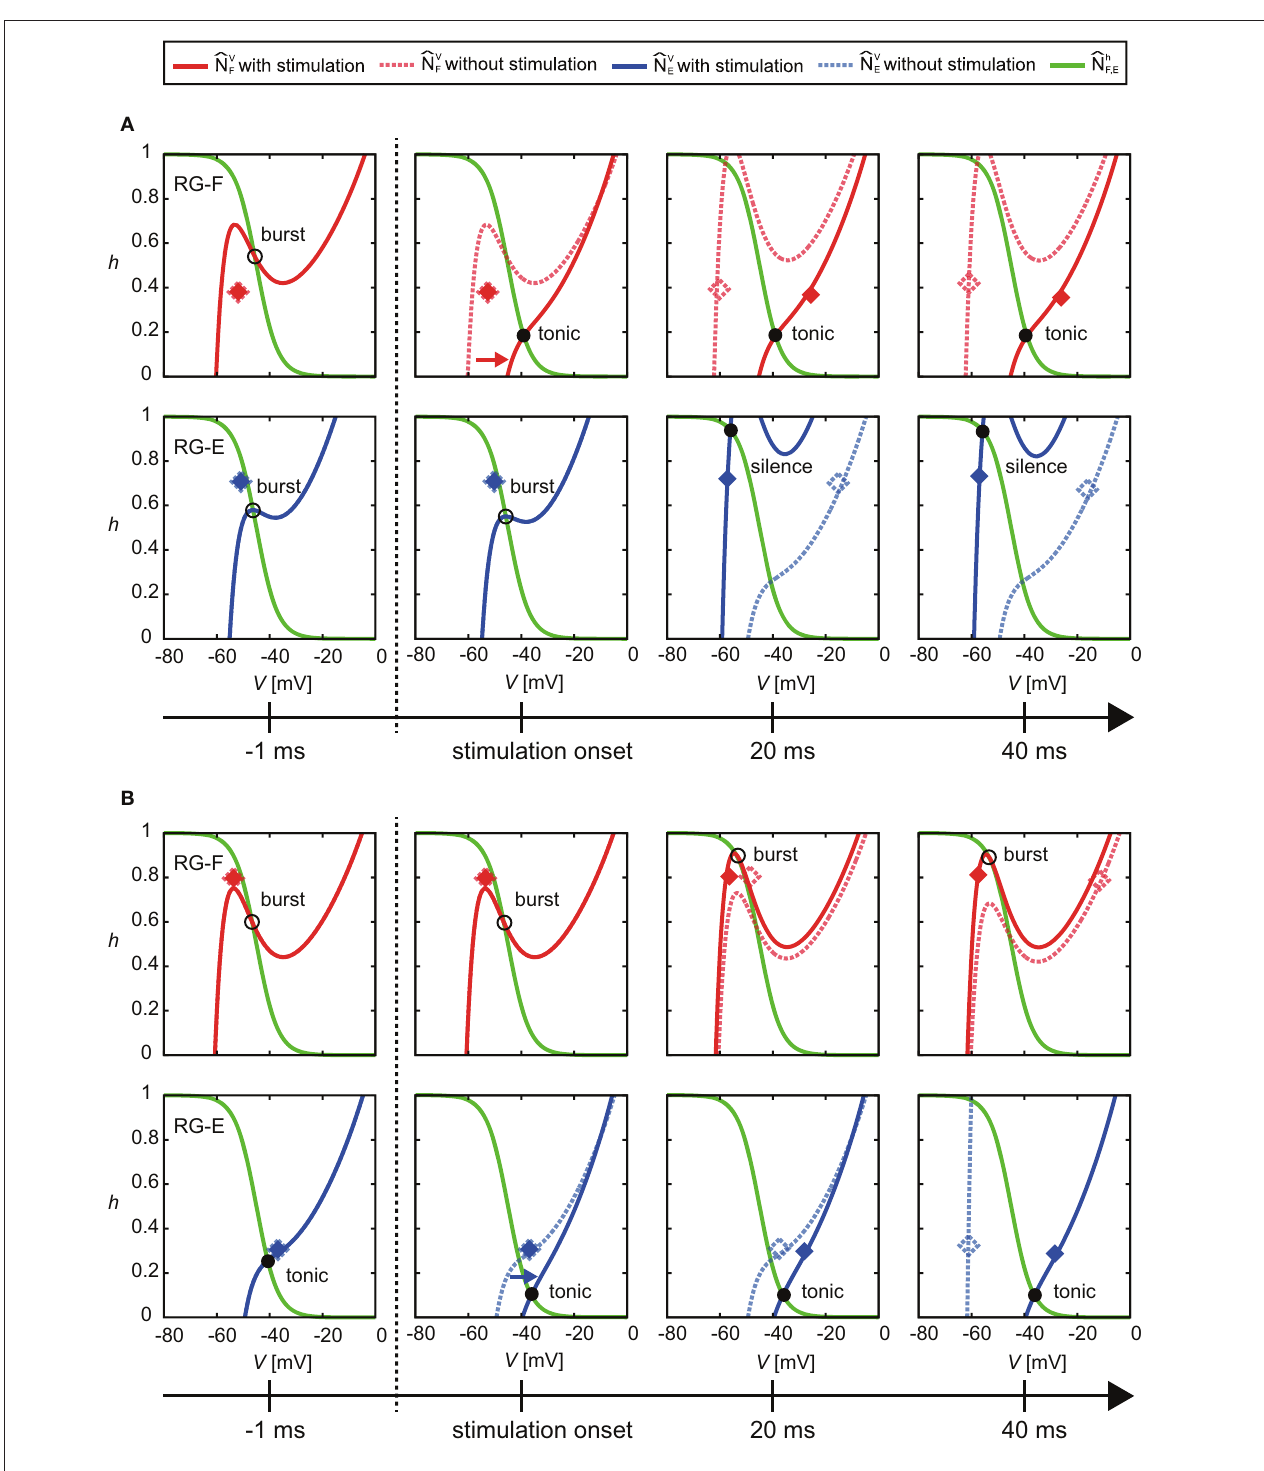
FIGURE 7 | Change of ˆ N V F and ˆ N V E by stimulation at the end of the active phase of (A) the flexor side ( φ s = 2.39rad) and (B) the extensor side ( φ s = 5.91rad). Solid and dotted lines show the results of the cases with and without the stimulation, respectively. Red and blue diamonds mark the positions of ( V F , h F ) and ( V E , h E ), respectively (filled diamonds for stimulation and open diamonds for non-stimulation). In (A) , the stimulation moved ˆ N V F to the right and changed the intersection of ˆ N h F and ˆ N V F from burst to tonic mode. Furthermore, ˆ N V F showed almost no change for a while. These prolonged the activity duration. In addition, they kept the intersection of ˆ N V E and ˆ N h E silence mode for a while, which also delayed the neural activity. In (B) , the stimulation moved ˆ N V E to the right and maintained the intersection of ˆ N h F and ˆ N V F in tonic mode. These prolonged the activity duration of the RG-E